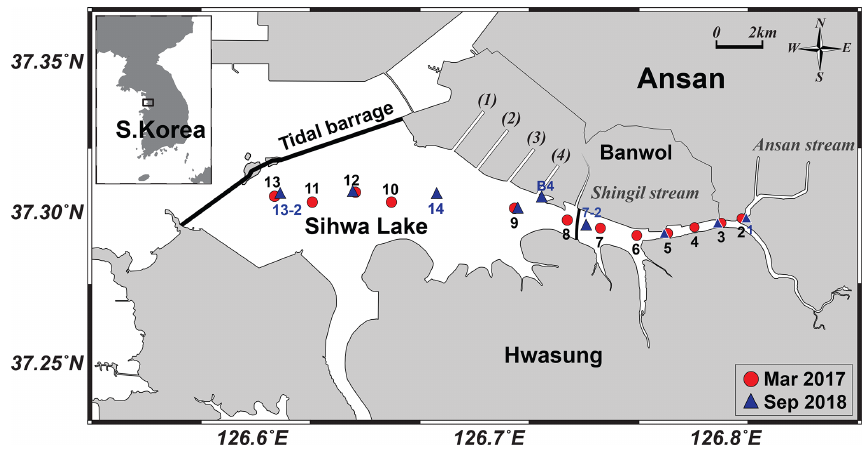
Figure 1. Map of sampling stations in Sihwa Lake, South